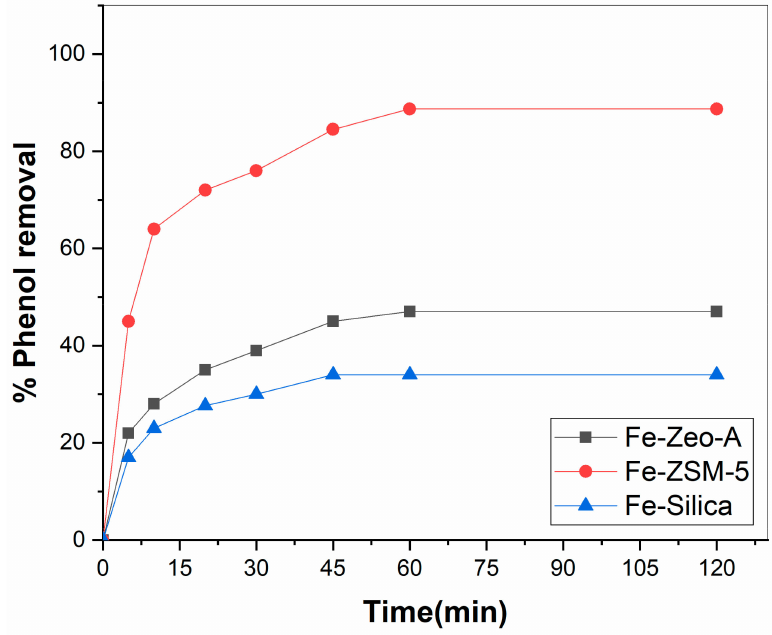
Figure 6. Heterogeneous Fenton degradation of phenol.